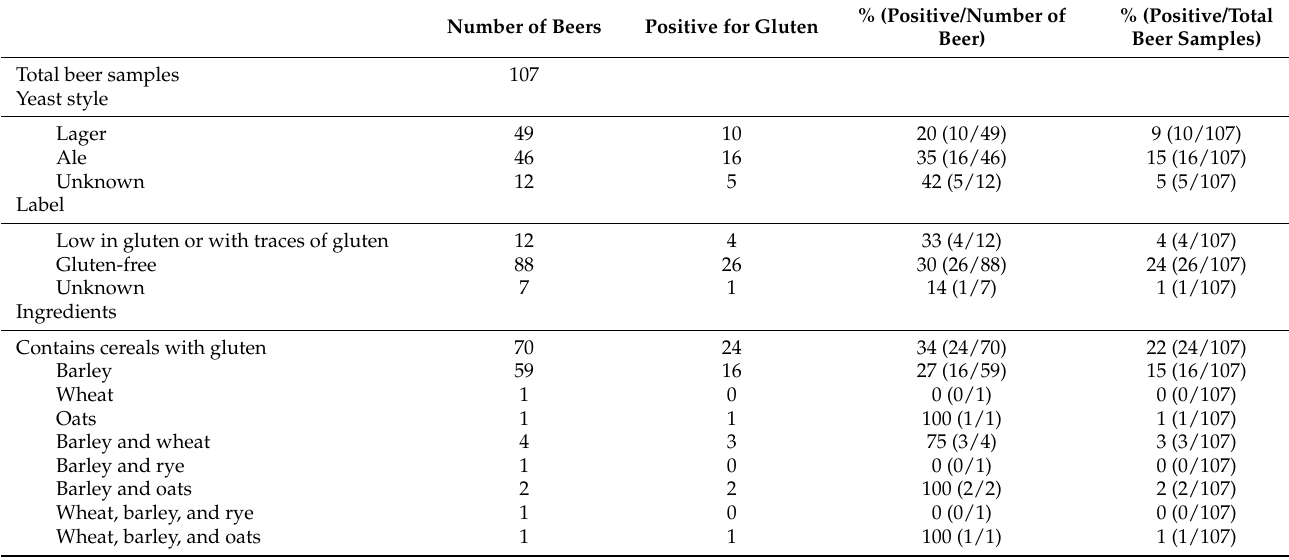
Table 3. Composition and characteristics of beer